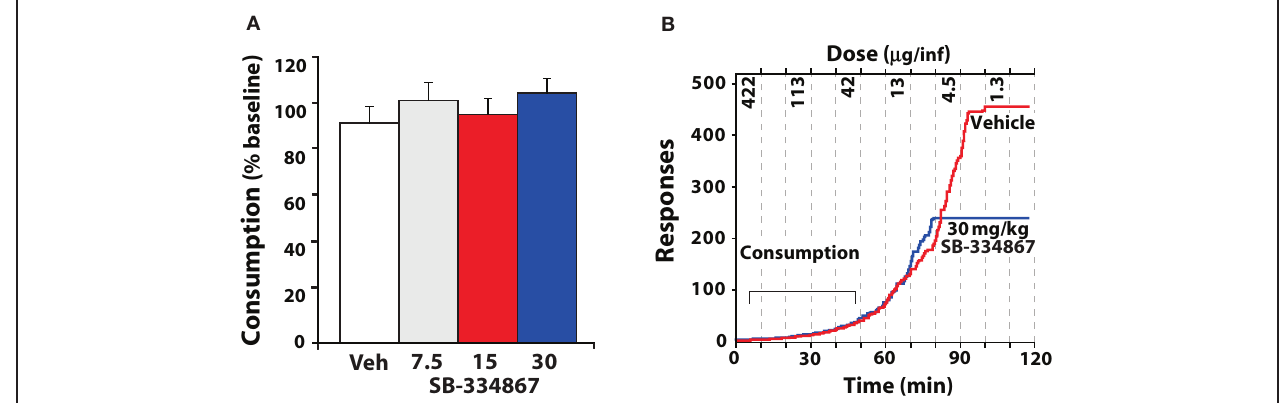
FIGURE 7 | SB-334867 reduces responding as the unit price of cocaine is increased. (A) Shown are the mean ± SEM percent baseline consumption of cocaine following i.p. injection of vehicle ( n = 9) or SB-334867 (7.5, 15, or 30mg/kg n = 9) on the threshold schedule of reinforcement. (B) Shown are the event records from an individual rat that received an i.p. injection of vehicle or 30mg/kg SB-334867. Dashed lines denote times in which cocaine